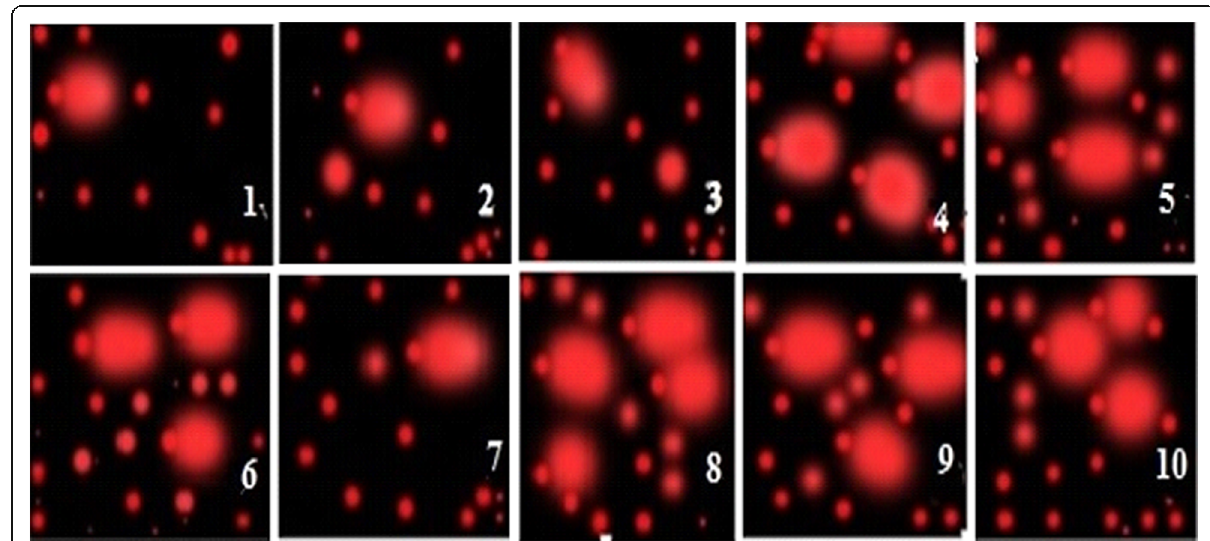
Fig. 2 DNA fragmentation pattern in liver cells of rats after different treatments. Slide (1): control group with no significant of DNA damage. Slide (2 and 3): P . ovata seed carbohydrates and fixed oil groups with non significant DNA damage. Slide (4): ketoprofen group with remarkable percent of DNA damage. Slides (5, 6, and 7): ketoprofen rats treated with P . ovata seed carbohydrates, P . ovata seed oil, and silymarin reference drug respectively, show lesser percent of DNA damage relative to ketoprofen group. Slides (8, 9, and 10): self recovery groups for 1 week, 2 weeks, and 3 weeks respectively with lesser percent of DNA damage relative to ketoprofen group. It is important to note that, P . ovata seed carbohydrates showing the most significant reduction in the percent of DNA